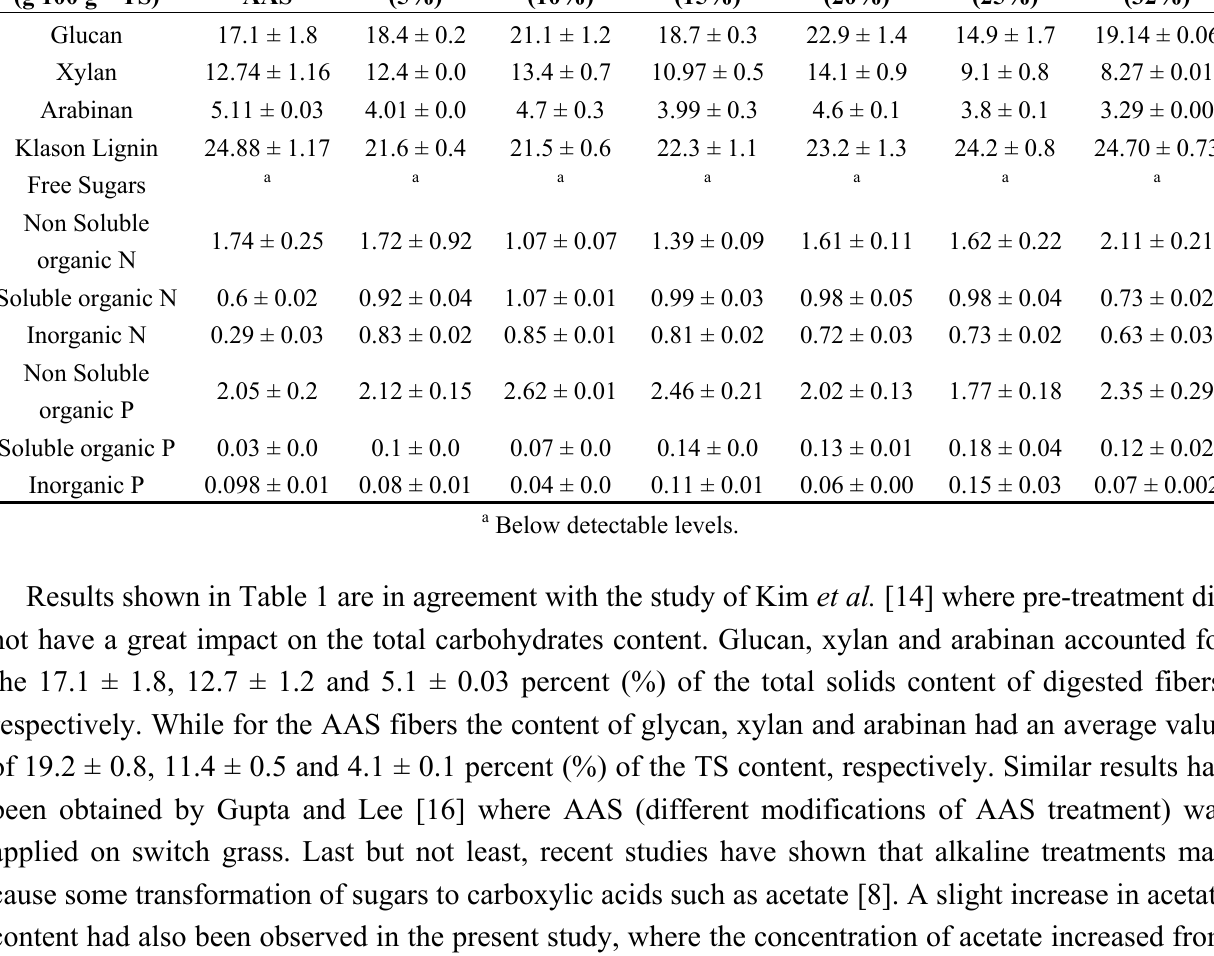
Table 1. Characterization results of digested fibers before and after 3-d AAS treatment.